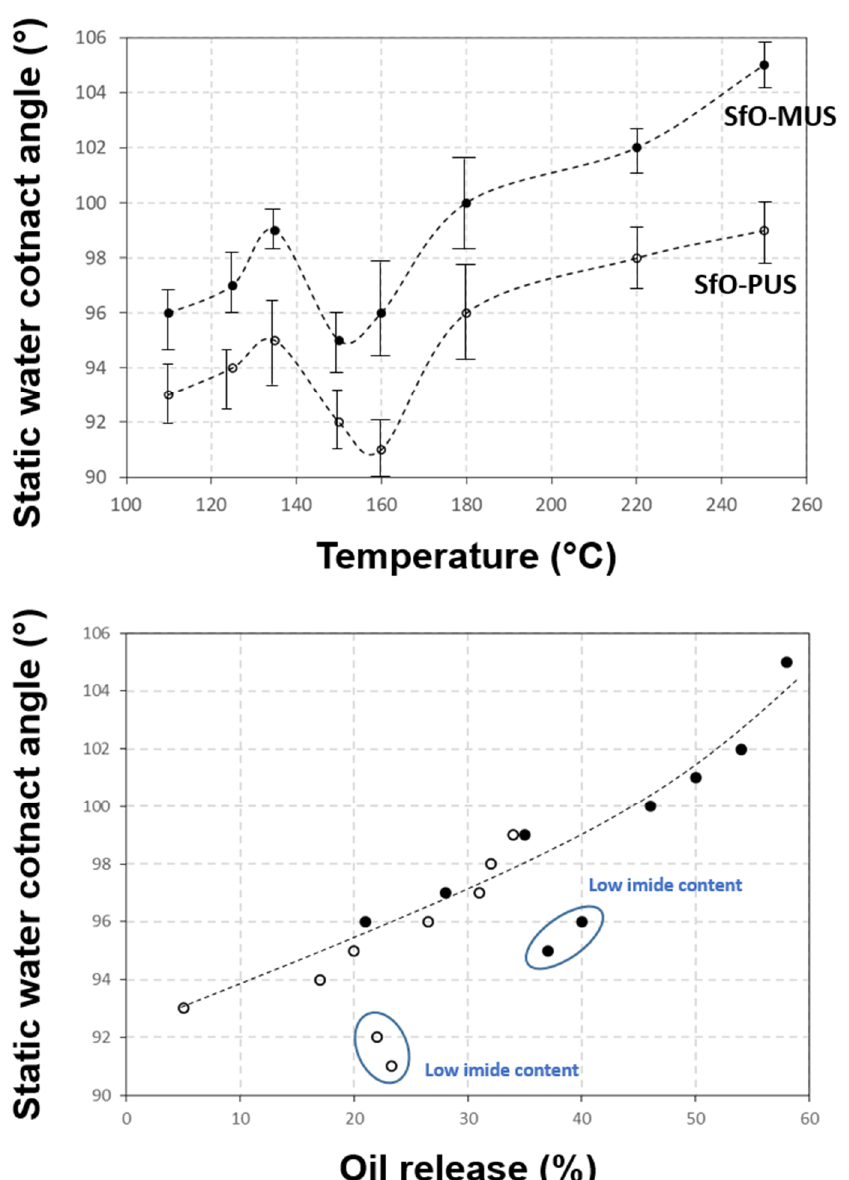
Figure 7. Hydrophobicity of SMI/SfO-PUS and SMI/SfO-MUS coatings on paper substrates after Figure 7 thermal oil release at different temperatures: ( a ) static water contact angles, ( b ) relation between water contact angle and oil